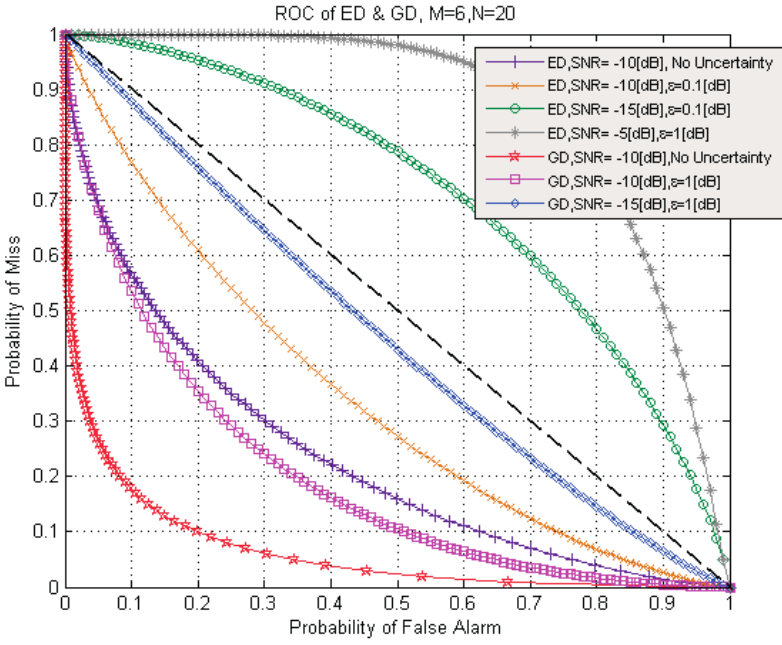
Figure 7. The complementary ROC curves for ED and GD.